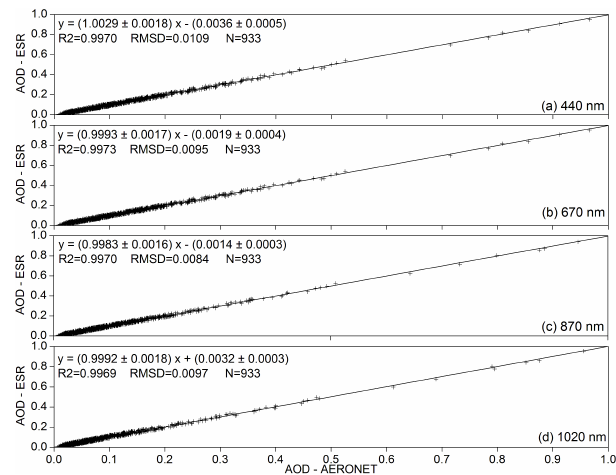
Fig. 3. Scatter plot and correspondent linear fitting for the AOD ob- tained by ESR and AERONET in mode 1 at (a) 440nm, (b) 675nm, (c) 870nm and (d) 1020nm